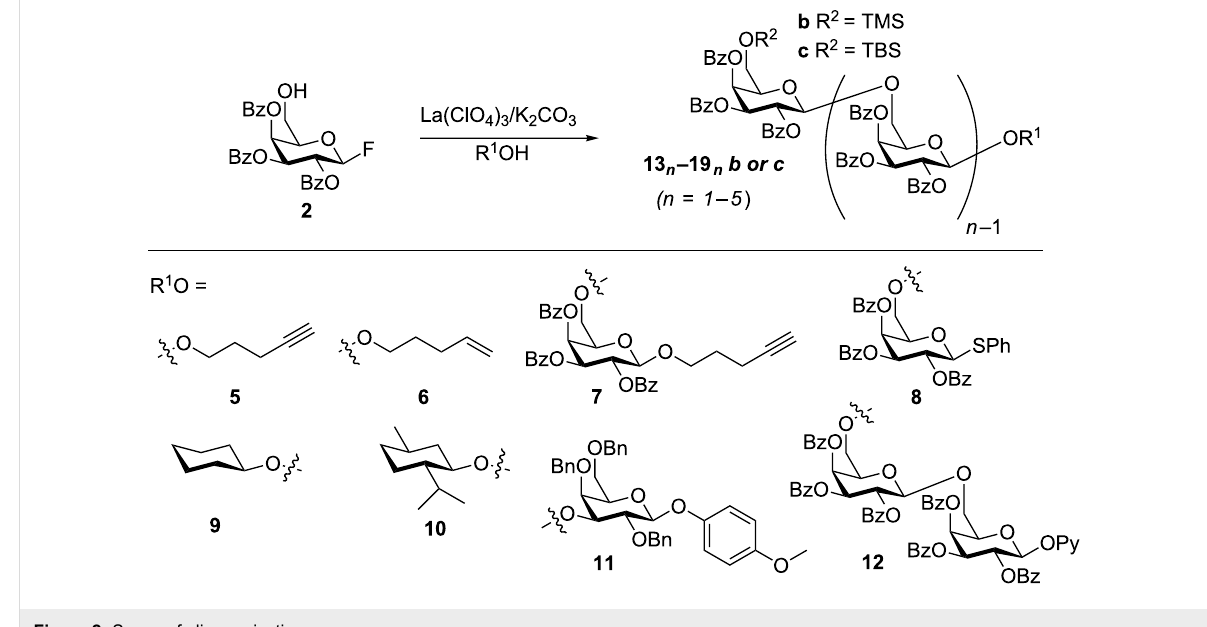
Figure 2: Scope of oligomerization.